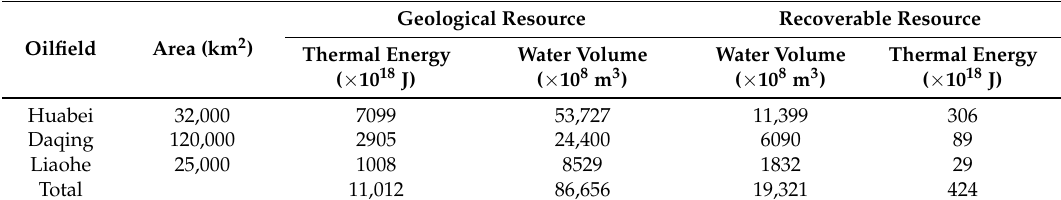
Table 2. Geothermal resource assessment of three oilfields.